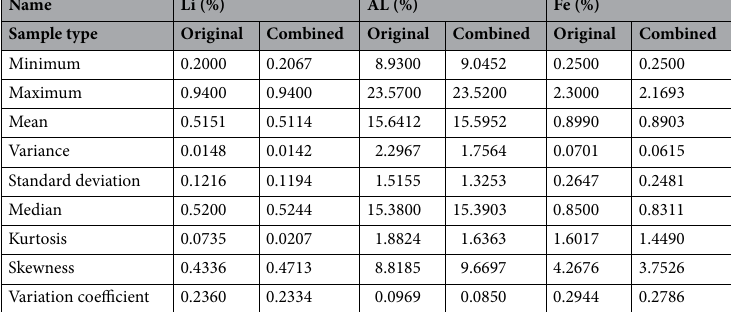
Table 1. Statistics of the OS and the